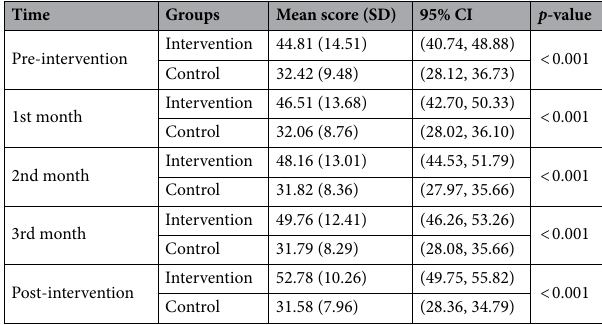
Table 4. ESE-M mean score among the two groups based on